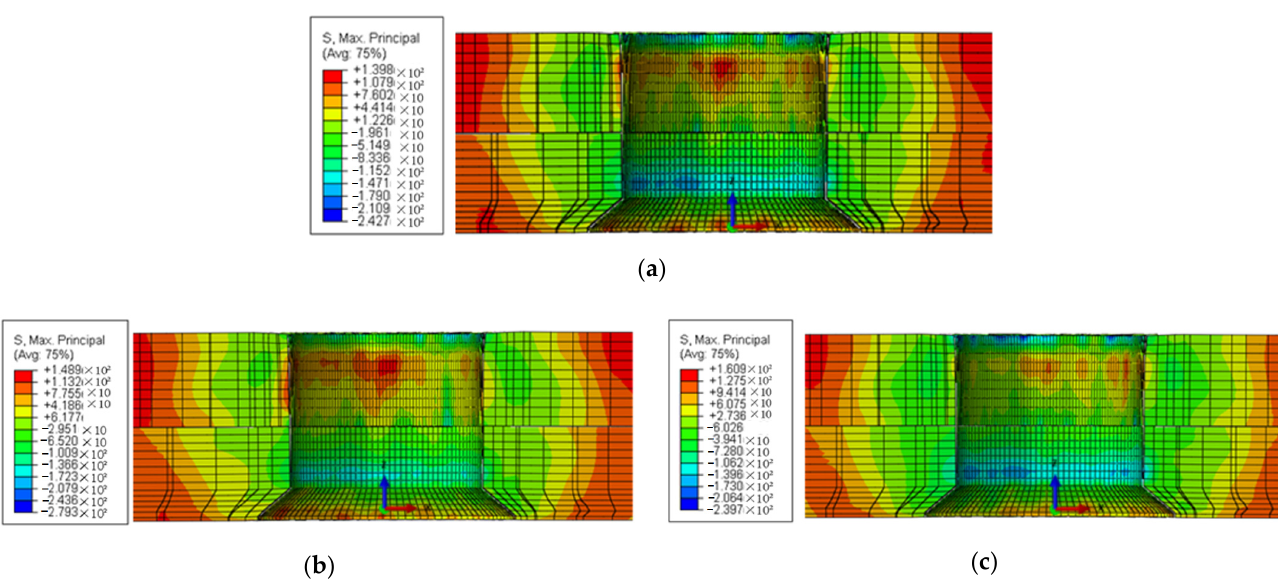
Figure 17. Distribution diagram of maximum principal stress around the hole of riveted parts (unit: MPa): ( a ) distribution of maximum principal stress of 0° standard part (0-0); ( b ) distribution of maximum principal stress of riveted parts of 1° in the 0° direction (0-1); ( c ) distribution of maximum principal stress of riveted parts of 1° in the 180° direction (180-1).